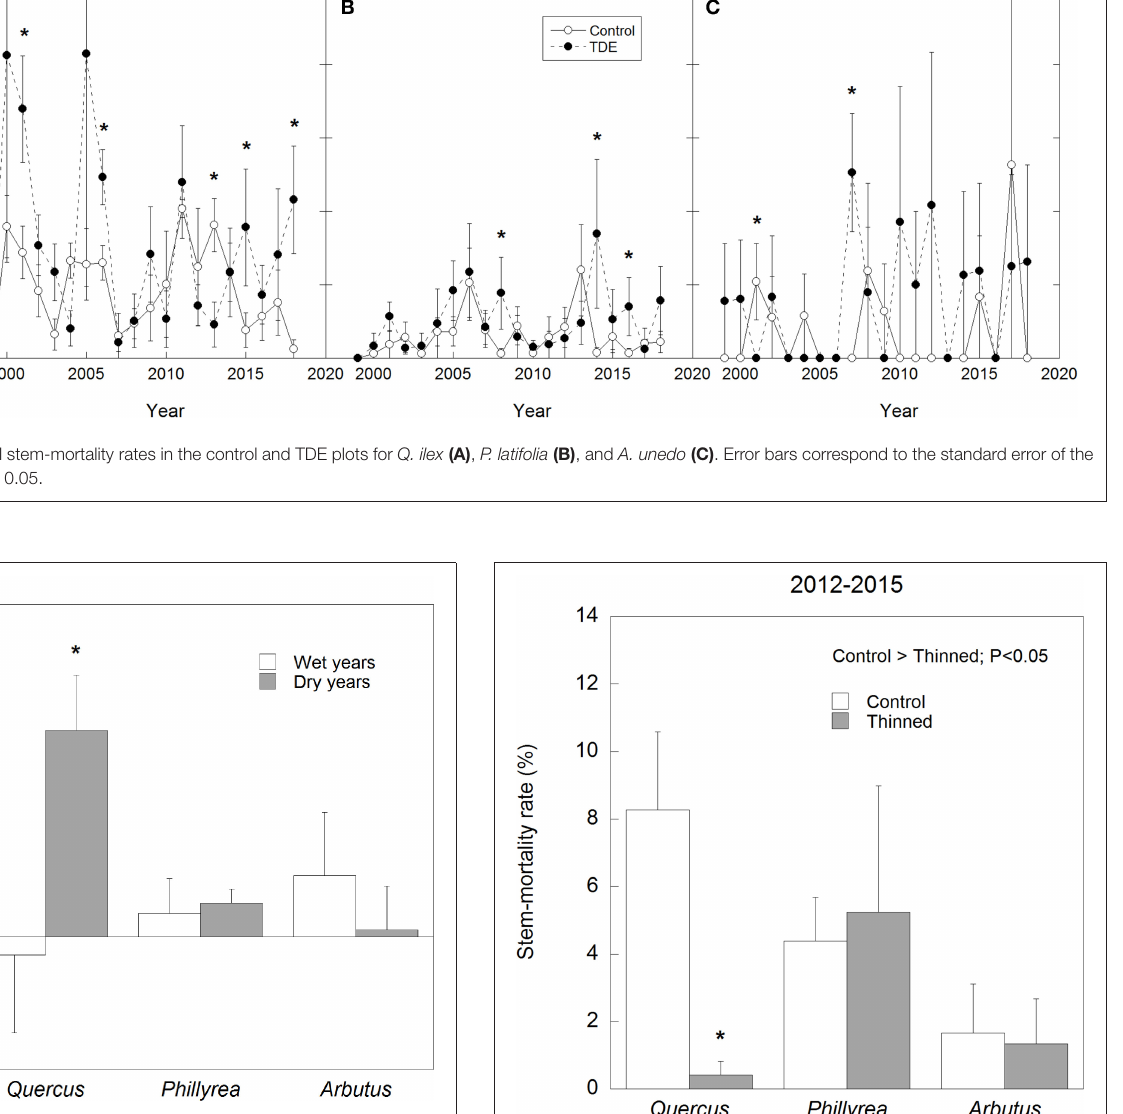
FIGURE 9 | Average stem-mortality rates in the control and thinned plots for each of the three species studied. Error bars correspond to the standard error of the mean ( n = 4). * P <